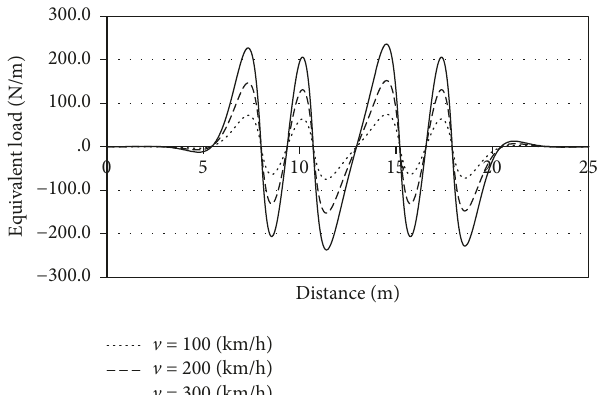
Figure 3: Equivalent load related to damping properties of rail foundation (reference values of viscous coefficients of fasteners and sleeper foundation).